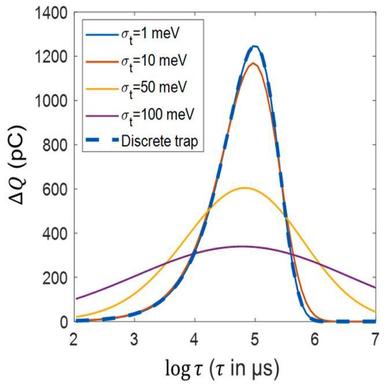
Illustration of the influence of the Gaussian width σt of a trap distribution on the Q-DLTS peak, and comparison with a discrete trap (dashed line). Increasing the trap distribution width broadens the Q-DLTS peak.